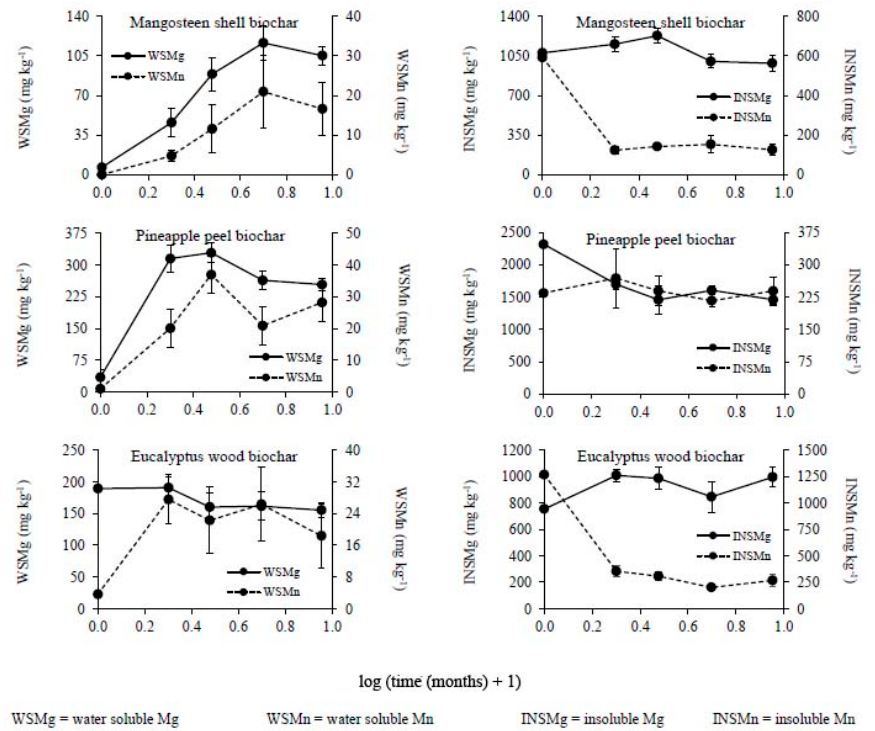
Figure 3. Plots of mean values and standard deviation for water soluble and insoluble Mg and Mn versus time in soil for three biochars recovered from soil at zero, 1, 2, 4, and 8 months. Mean values and SD are for nine soils. Soil Syst. 2019 , 3 , x FOR PEER REVIEW